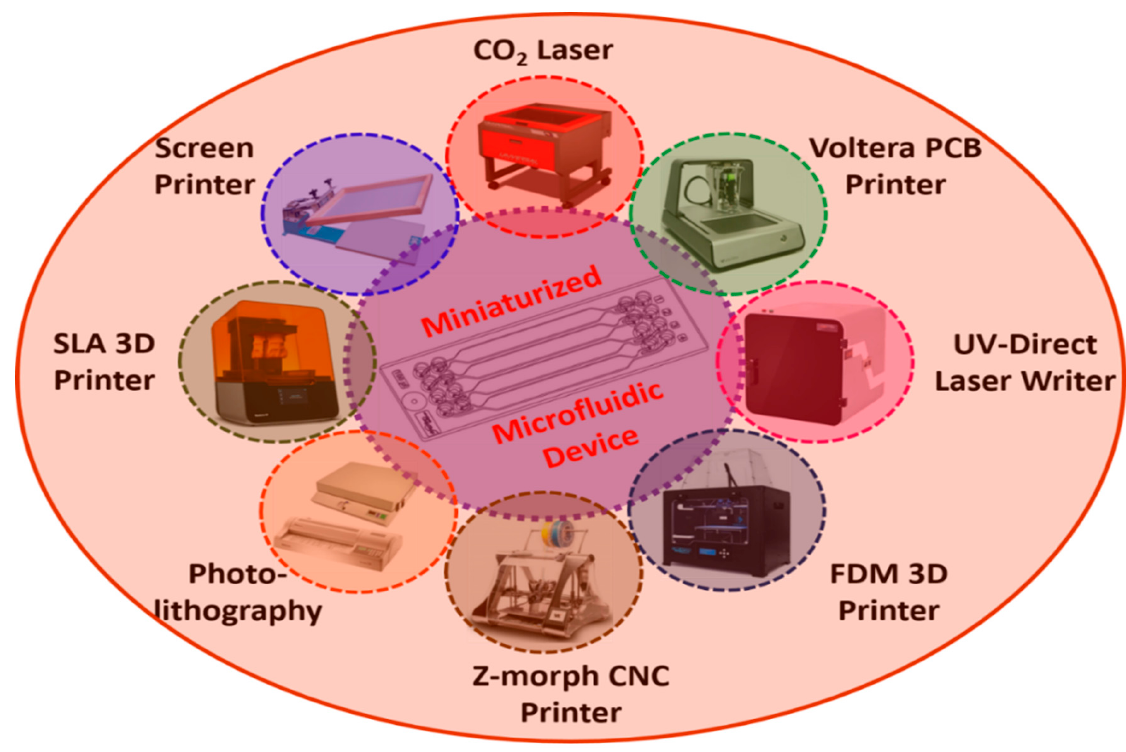
Figure 7. Schematic representation of various fabrication techniques used in the development of miniaturized microfluidic biosensors.